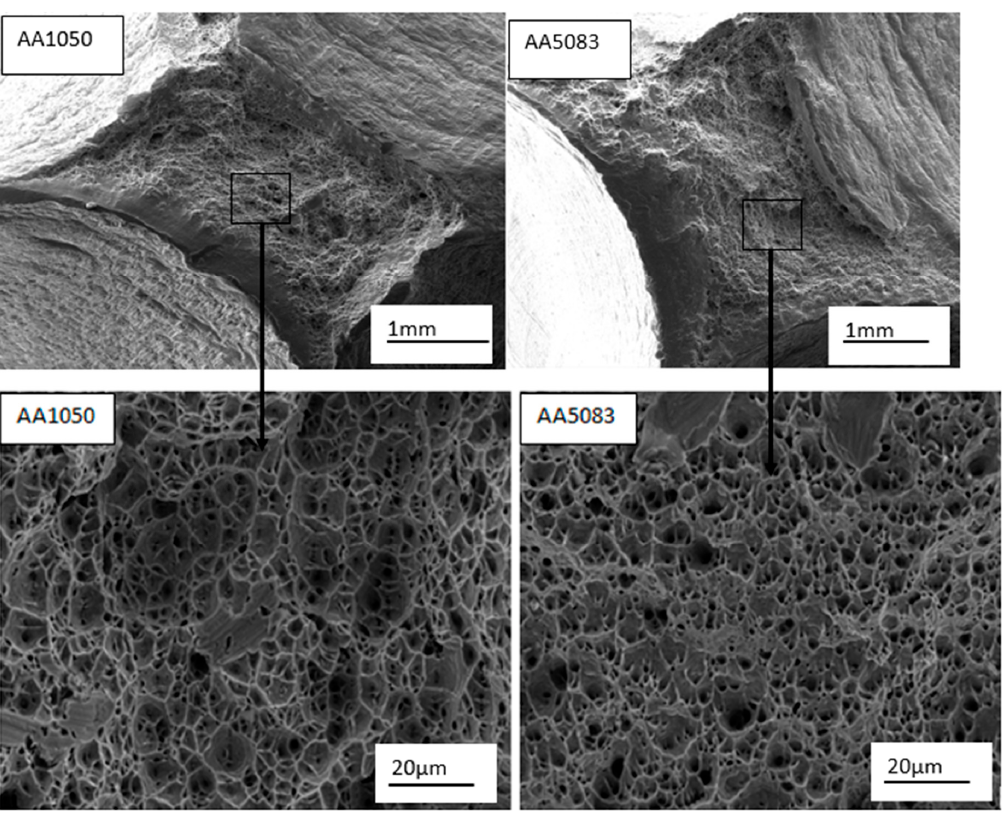
Figure 16. Micrograph of parent material .